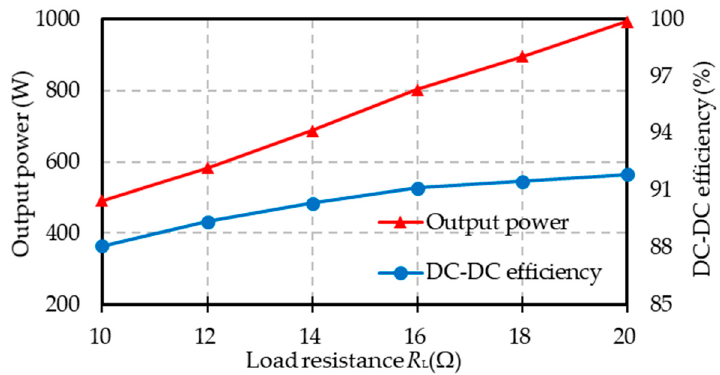
Figure 12. Output power/efficiency variation with load resistance.